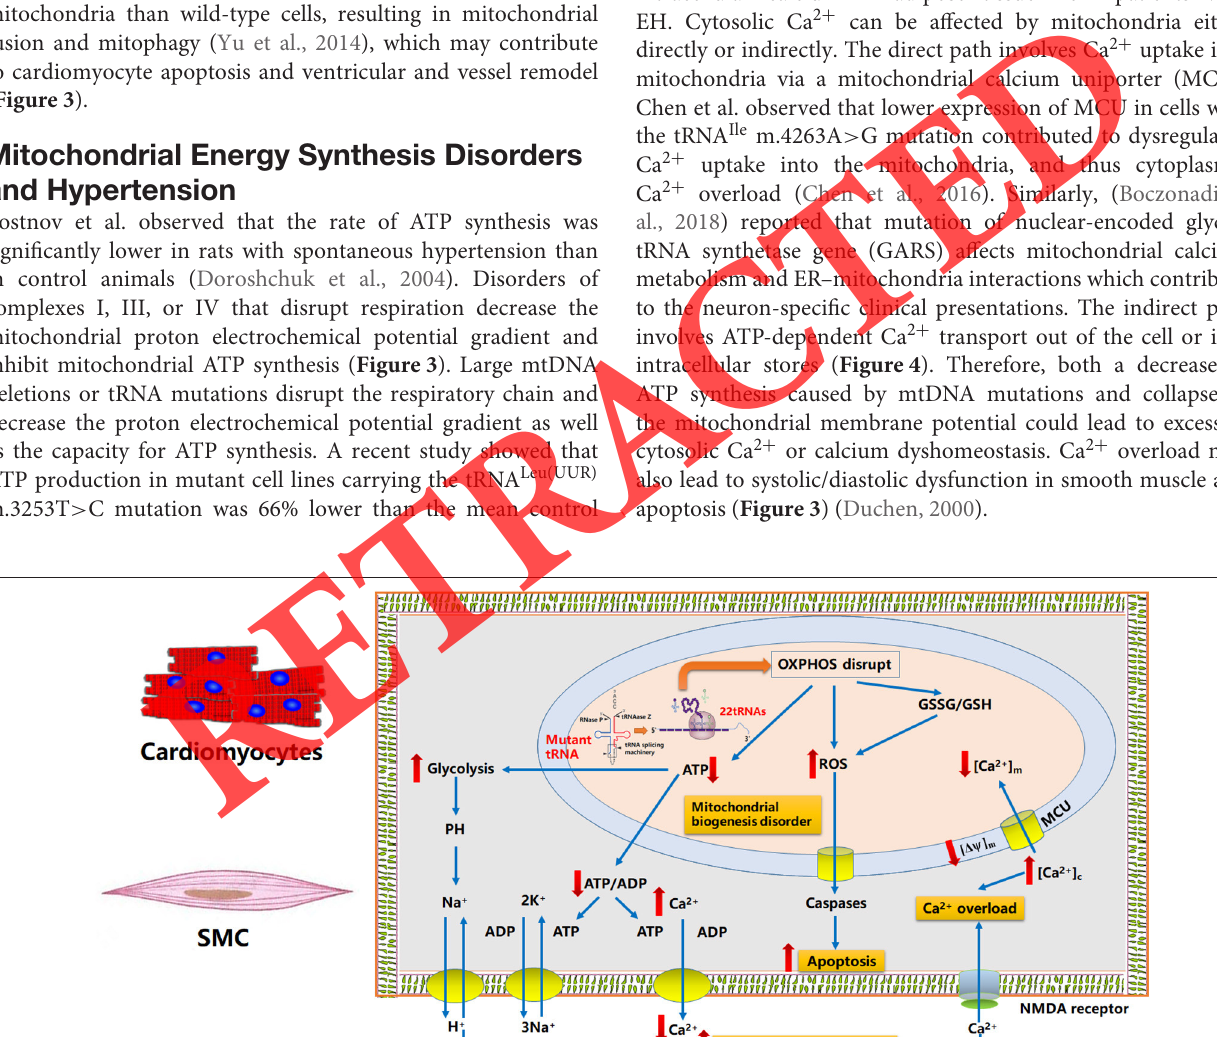
Frontiers in Cell and Developmental Biology |